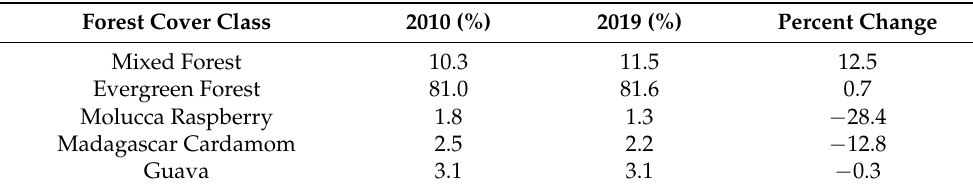
Table 6. Percentage of forest cover types in 2010 and 2019 observed within the boundary of the BNR (Figure